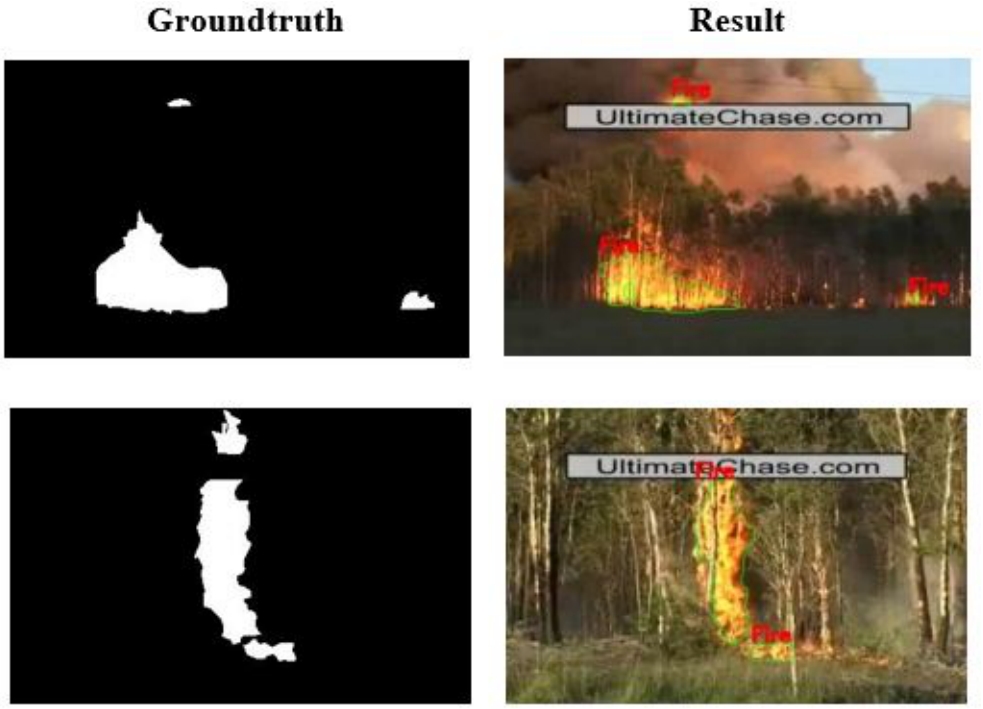
Figure 8. The sample of fire detection result using the proposed framework; ( top row) successful fire detection and ( bottom row) failed fire